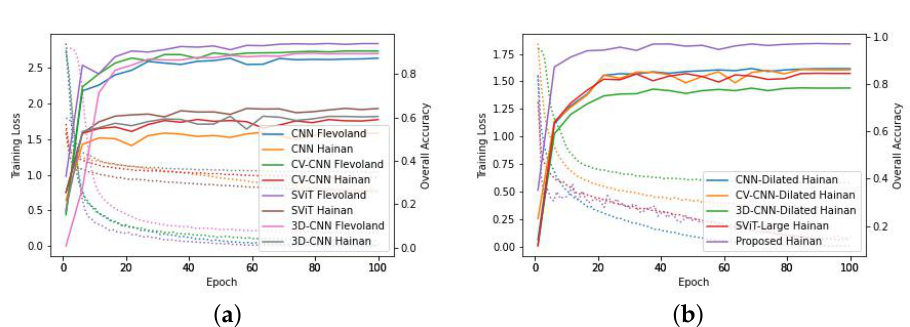
Figure 14. The curves of training loss and overall accuracy. ( a ) The curves of the four compared methods on the C-band of the Flevoland dataset and Hainan Dataset. ( b ) The curves of the four modified compared methods and the proposed method on the C-band of Hainan